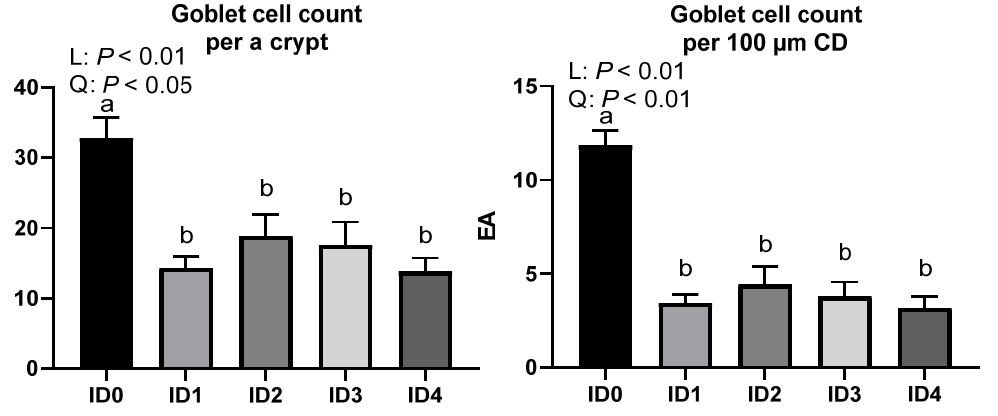
Figure 8. Effects of different infection doses of Eimeria tenella on goblet cell number per a crypt and